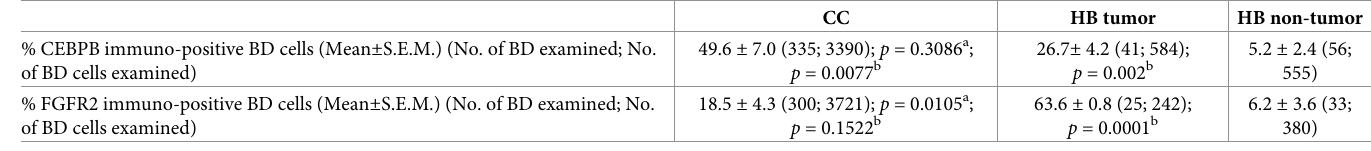
Table 2. Comparison of % CEBPB and FRGR2 immuno-positive bile duct cells between CC, HB tumor and non-tumor